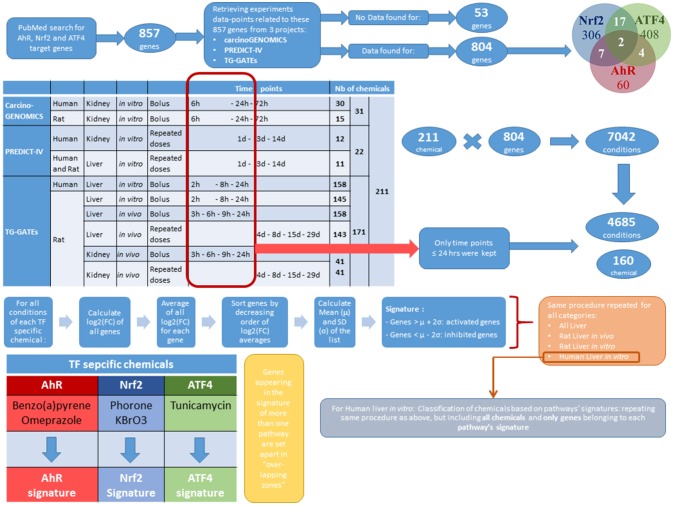
Methods summarizing workflow.